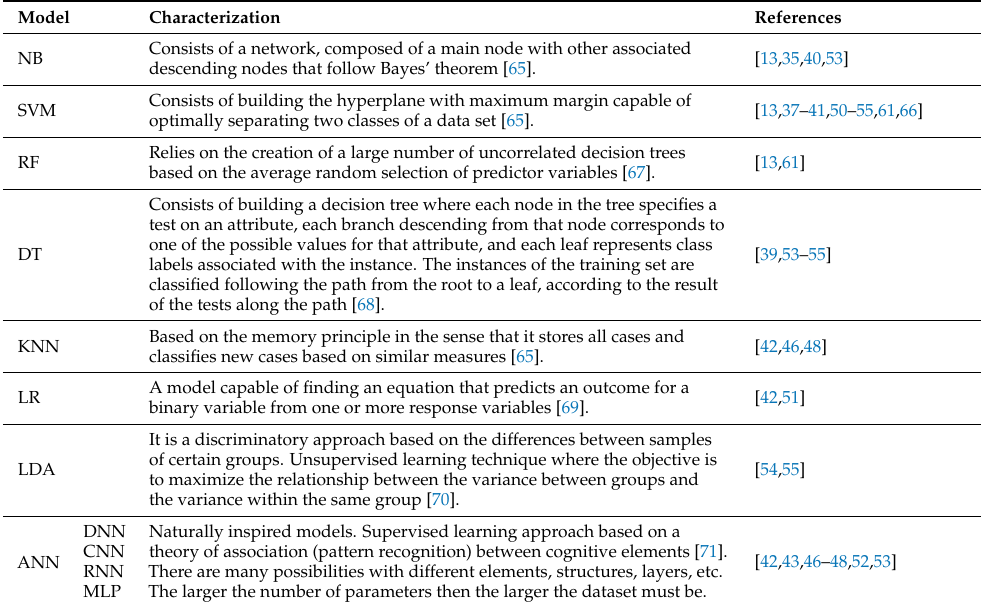
Table 5. Most significantly used classification models.